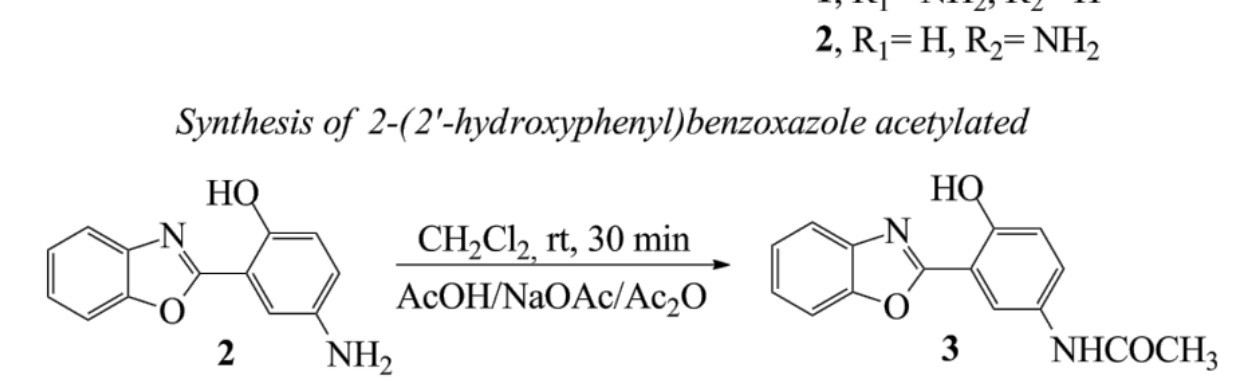
FIGURE 1 - Scheme of synthesis of benzoxazoles compounds